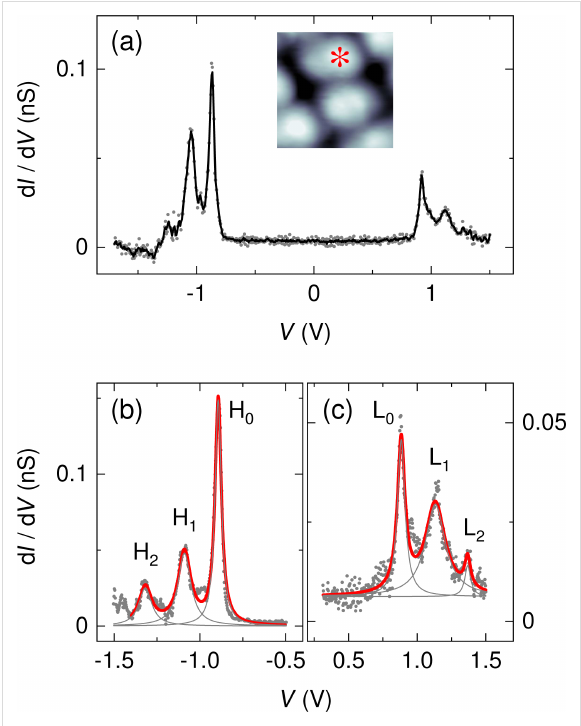
Figure 7: (a) Spectrum of d I /d V (dots) recorded above a C 42 H 28 phe- nyl group on graphene-covered Pt(111) (feedback loop parameters: − 1.5 V, 15 pA). The solid line represents smoothed data. Inset: STM image of a single C 42 H 28 molecule on graphene-covered Pt(111) (2 V, 20 pA, 2 × 2 nm 2 ) with an asterisk marking the position of spectrosco- py. (b) Close-up d I /d V spectrum (dots) of the HOMO (H 0 ) spectral fine structure (H 1 , H 2 ) (feedback loop parameters: − 1.5 V, 30 pA). The thick solid line represents a fit of three Lorentzian line shapes (thin gray lines) and a constant background to the data. (c) Like (b), for the LUMO (L 0 ) with vibronic fine structure (L 1 , L 2 ) (feedback loop parame- ters: 1.5 V, 20